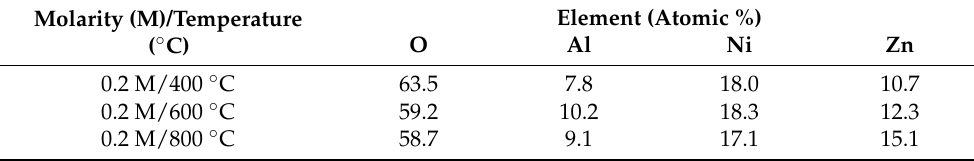
Table 2. EDS results of NiO/ZnO/Al 2 O 3 particles produced at different temperatures.